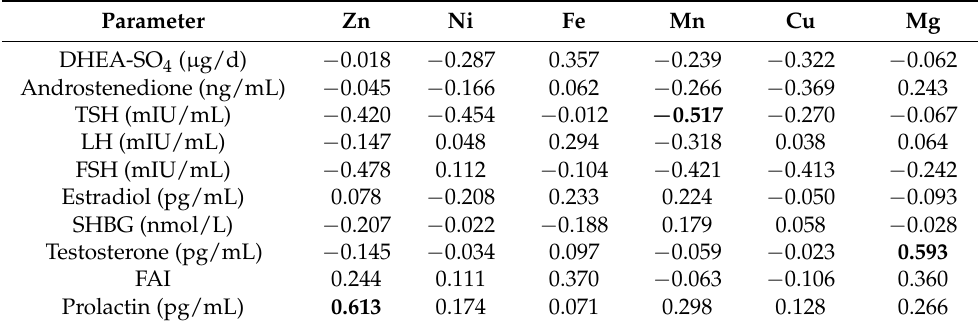
Table 5. Correlation coefficients between the level of trace elements ( µ g/mL) and the biochemical parameters in obese women with PCOS (BMI ≥